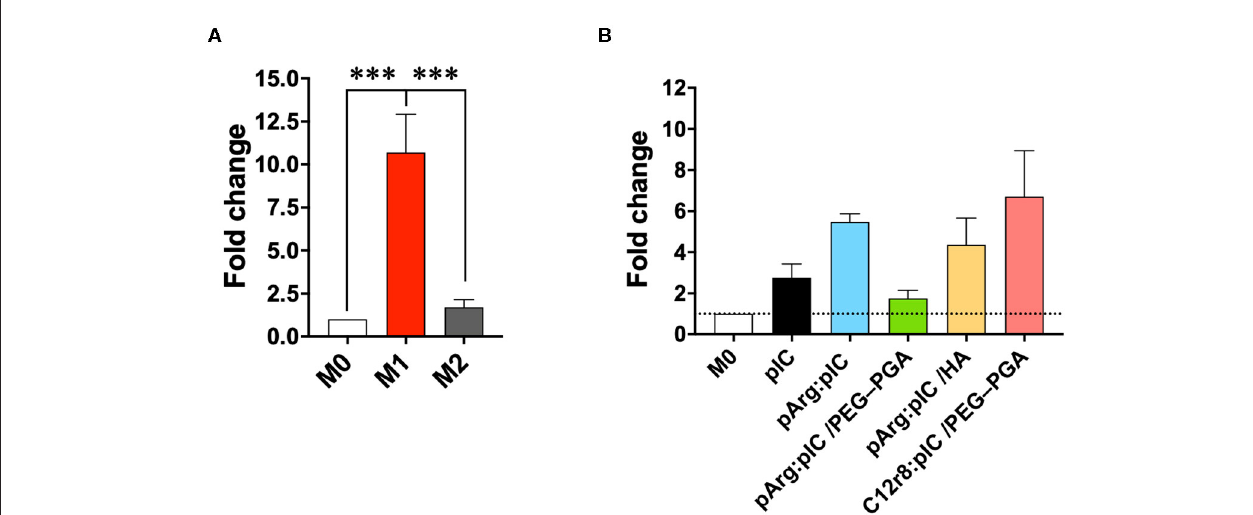
FIGURE 5 | mRNA production of different M1/M2 associated factors. Fold change in the mRNA levels of IRF7 in (A) prototypic M1/M2 macrophages and in (B) M0 macrophages treated with the different nanocomplexes after 8h of incubation. The dose of poly(I:C) was 5 µ g/mL. Values represent mean ± SD ( N = 4). Statistical comparison was done using an ordinary one-way ANOVA followed by a Tukey’s comparison test between groups. Statistically significant differences are represented as *** p < 0.005. C12r8, laurate-octaarginine; HA, hyaluronic acid; pArg, poly-arginine; PEG–PGA, pegylated polyglutamic acid; pIC,